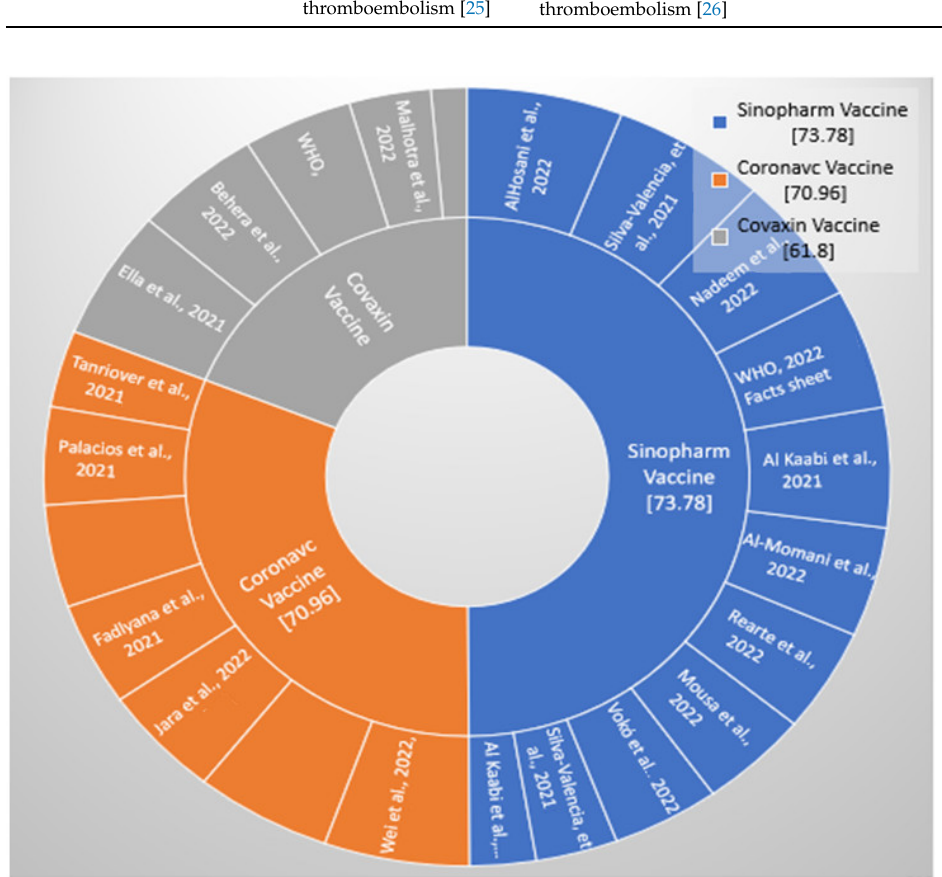
Figure 2. Distribution of studies selected for the efficacy of the Sinopharm, CoronaVac, and Covaxin vaccines for the prevention of COVID-19 [10,11,14,15,29,30–32,34–37,40–44,47–49].